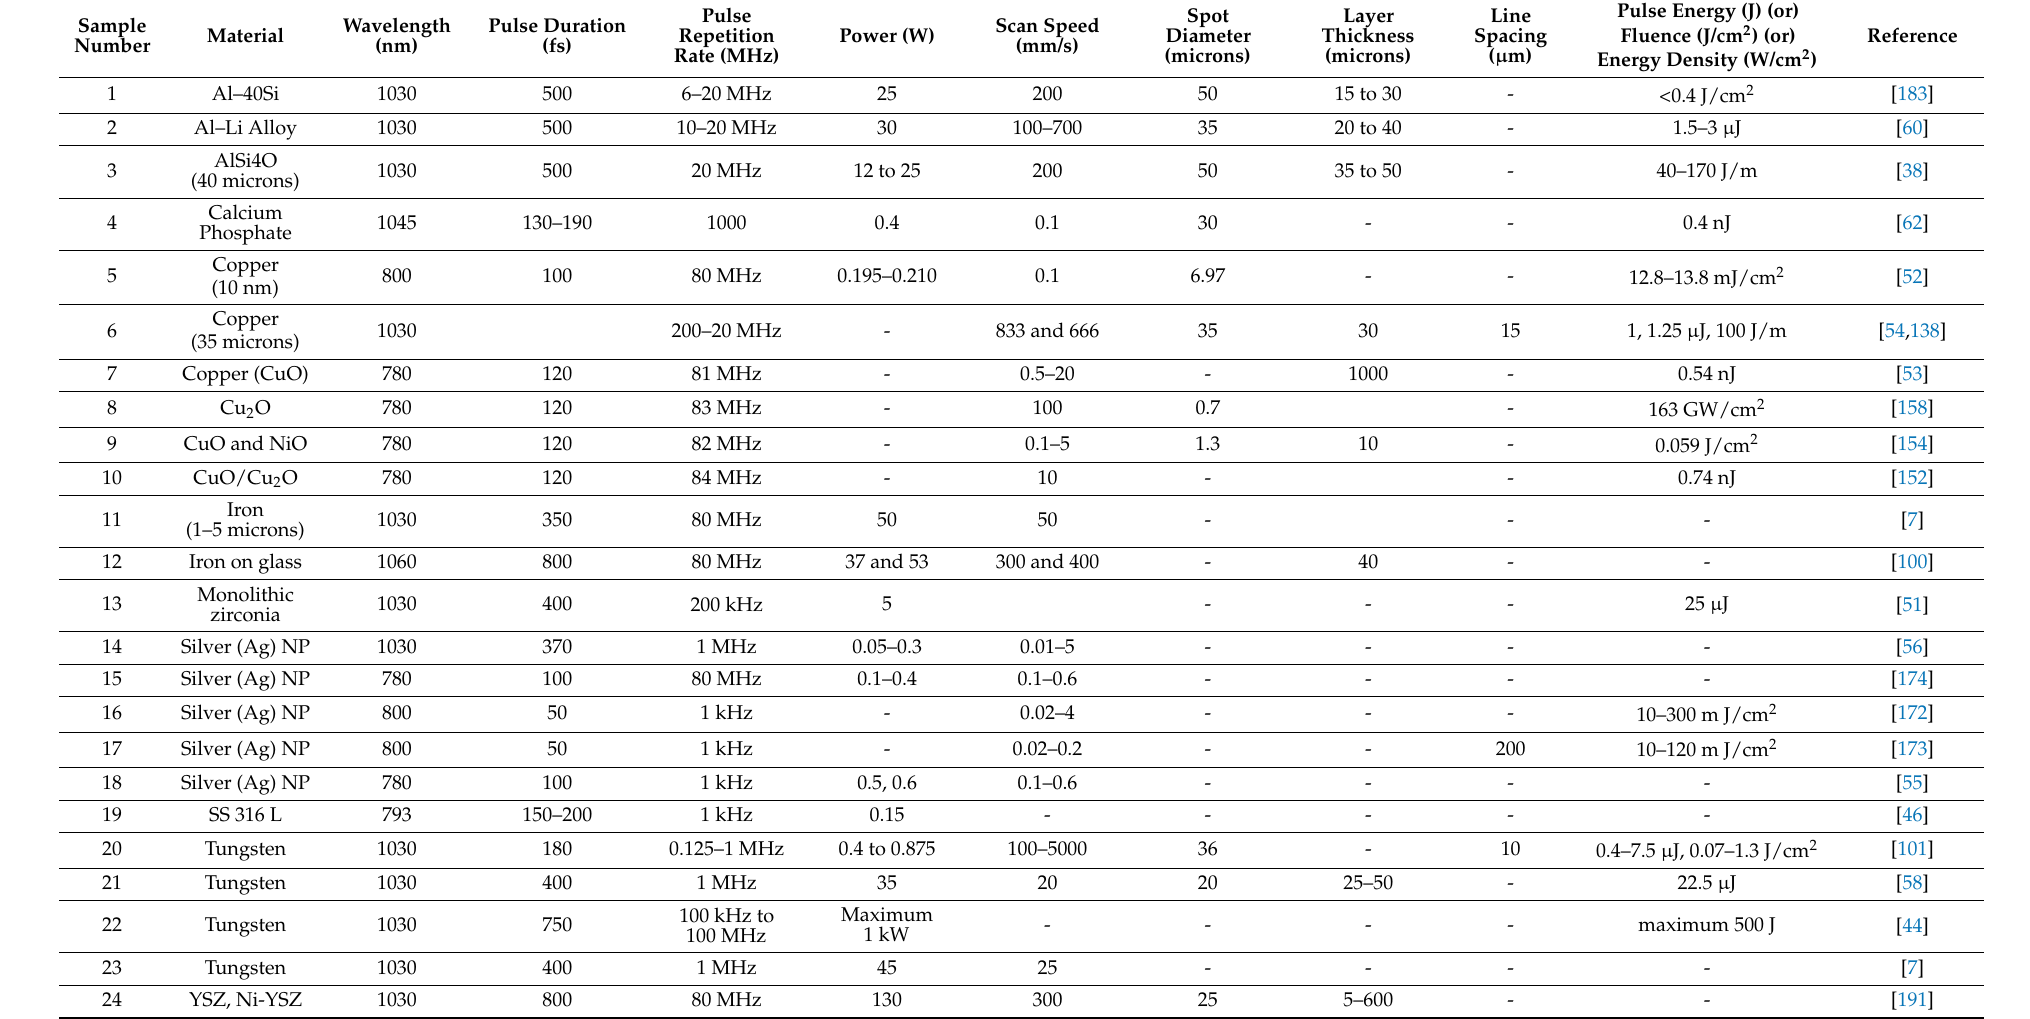
Table 7. Showing materials processed through femtosecond lasers with different process